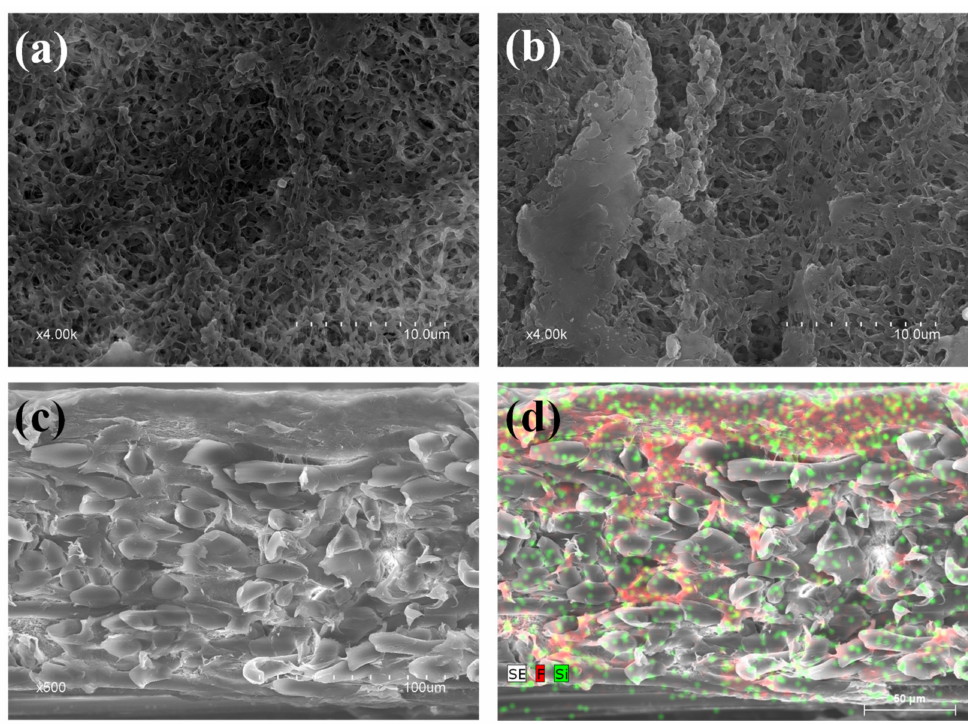
Figure 6. FESEM images of ( a ) non-modified PVDF (nmPVDF) surface, ( b ) modified PVDF (mPVDF max ) surface, ( c ) modified PVDF (mPVDF max ) cross-section, and ( d ) EDX mapping of modi- fied PVDF (mPVDF max ) cross-section (red dots for F and green dots for